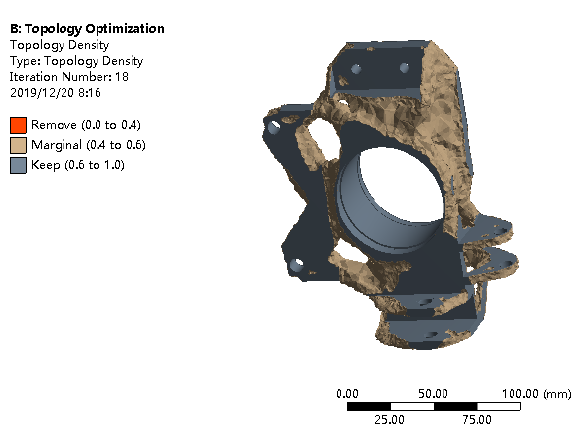
Figure 7. Topology optimization result.